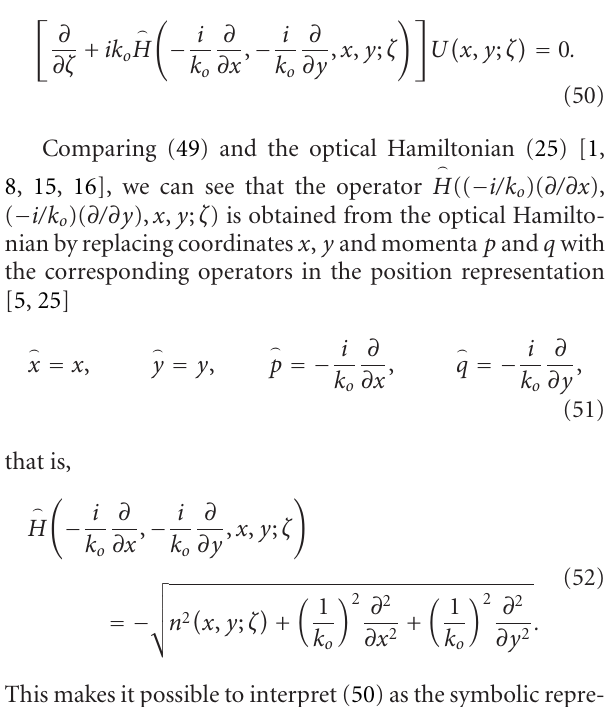
Using the operator representation of the Taylor series (Appendix B), the function U ( x − ε ˙ x , y − ε ˙ y ; ζ ) can be given